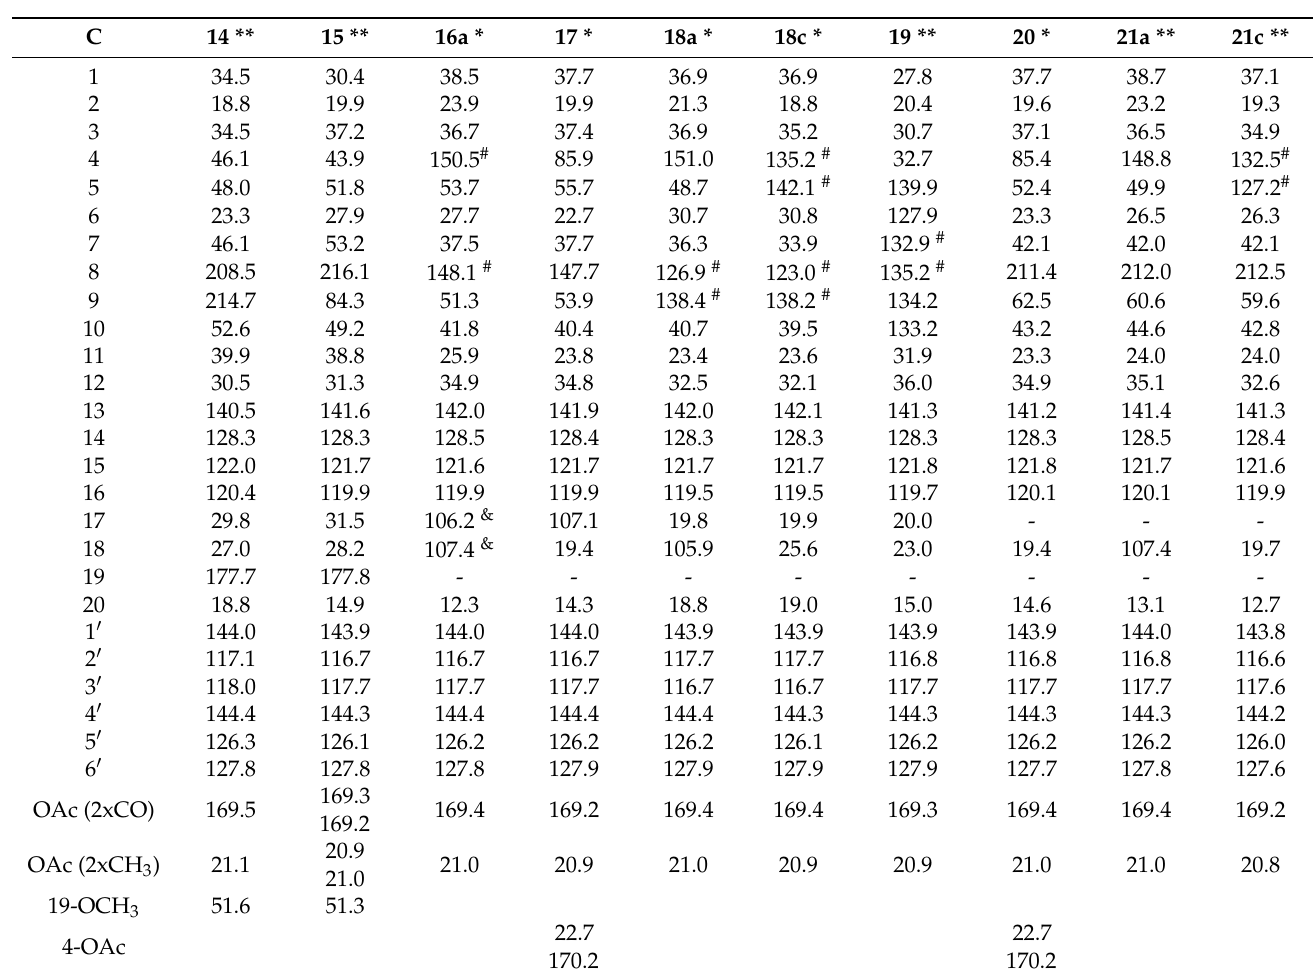
Table 5. 13 C-NMR data for compounds 14 – 21 ( δ ppm).